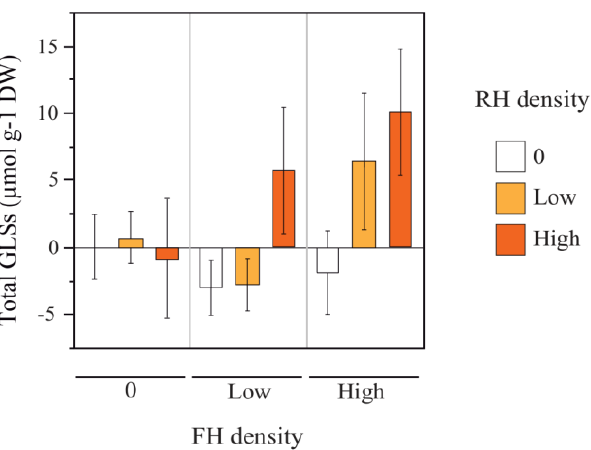
Figure 3. Root herbivore (RH) and floral herbivore (FH) density (0 or absence, low, and high) effects on total glucosinolate (GLS) concentrations. Shown values (mean ± SE) are relative to the focal treatment (mean RH 0 FH 0 = 0, plants without RH and FH; see absolute values in Supplementary Material 2, Figure S1). As follows: 0 FH density = absence of FH, FH 0 plants; low FH density = FH 1 plants, one FH individual; high FH density = FH 2 plants, two FH individuals . White bars are shown for 0 RH density (RH 0 plants, absence of RH), orange bars are shown for low RH density (RH 1 plants, one RH individual), red bars are shown for high RH density (RH 2 plants, two RH individuals).